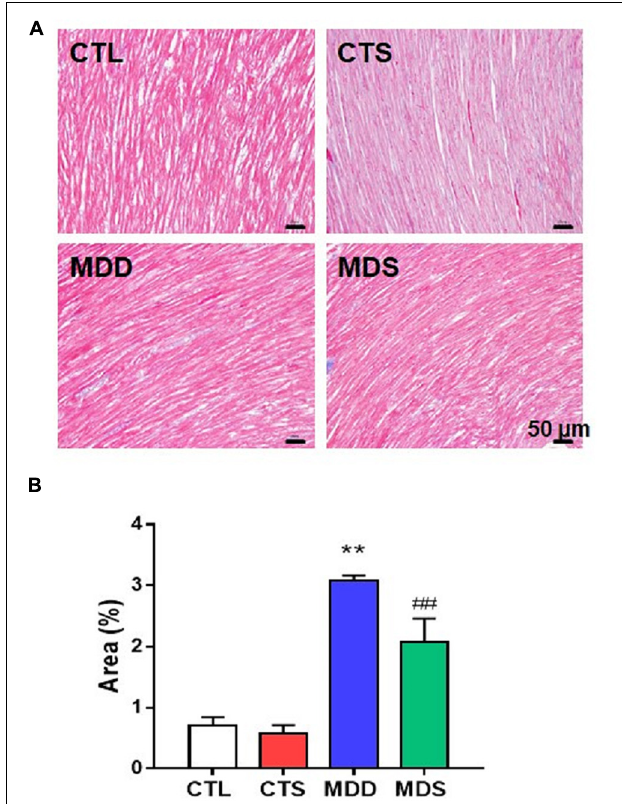
FIGURE 7 | Summary of schematic showing of the reversal effect of SA4503 effects on AA. Inflammatory factors causing AA substrate. Activated immune cell relates AA to TNF- α and TGF- β /Smad2/3 pathway causes altered ion functions, downregulation of Cx40 and Cx43, and atrial